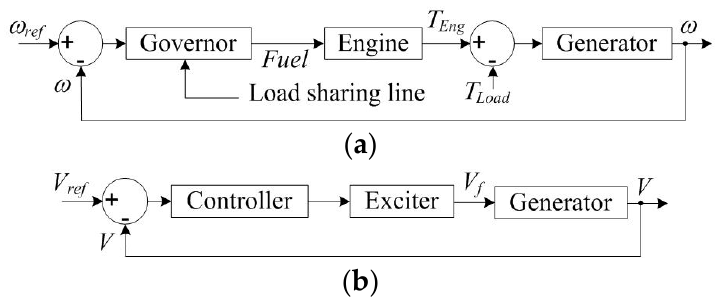
Figure 4. ( a ) Isochronous speed controller; ( b ) automatic voltage regulator.